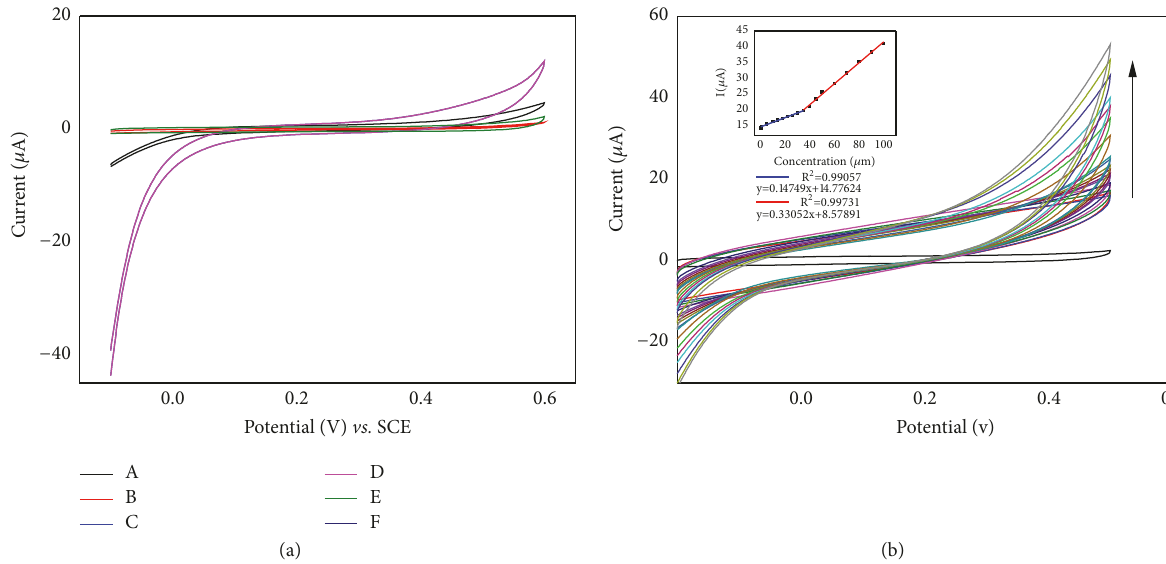
Figure 4: (a) CVs of electrodes in the absence (A-C) and presence (D-F) of H 2 O 2 (3mM) in N 2 -saturated 0.1 M PBS (pH = 7.0). Scan rate: 20mVs -1 . (A and E) Bare GCE (curves B and F) AuNPs/GCE (curves C and D) np-AuNPs/GCE. (b) CVs of np-AuNPs/GCE in 0.1 M PBS (pH = 7.0) with N 2 toward different concentrations of H 2 O 2 over the range of 0.5 𝜇 M to 100 𝜇 M. Applied potential: 0.55 V. Inset: plot of electrocatalytic current of H 2 O 2 versus its